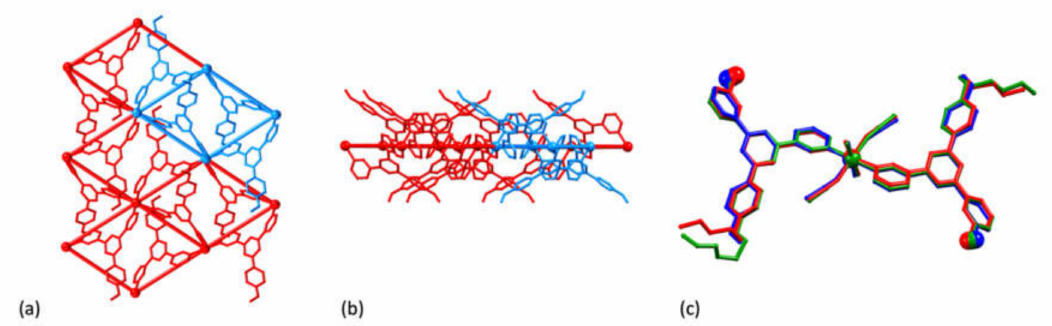
Figure 6. Part of one (4,4) net in [{Co( 1 ) 2 (NCS) 2 } . 3MeOH] n with the net defined by the lines connecting the Co atoms viewed ( a ) from above and ( b ) into the plane containing the Co atoms; H atoms, thiocyanato ligands and solvent molecules are omitted. One rhombus with the four ligands 1 that link Co centres is highlighted in blue. CSD refcode FOXQUH [19]. ( c ) Overlay of the repeat units with symmetry-generated atoms in [{Co( 1 ) 2 (NCS) 2 } . 3MeOH] n (in blue), [Co 2 ( 5 ) 4 (NCS) 4 ] n (in red) and [Co( 6 ) 2 (NCS) 2 ] n (in green).